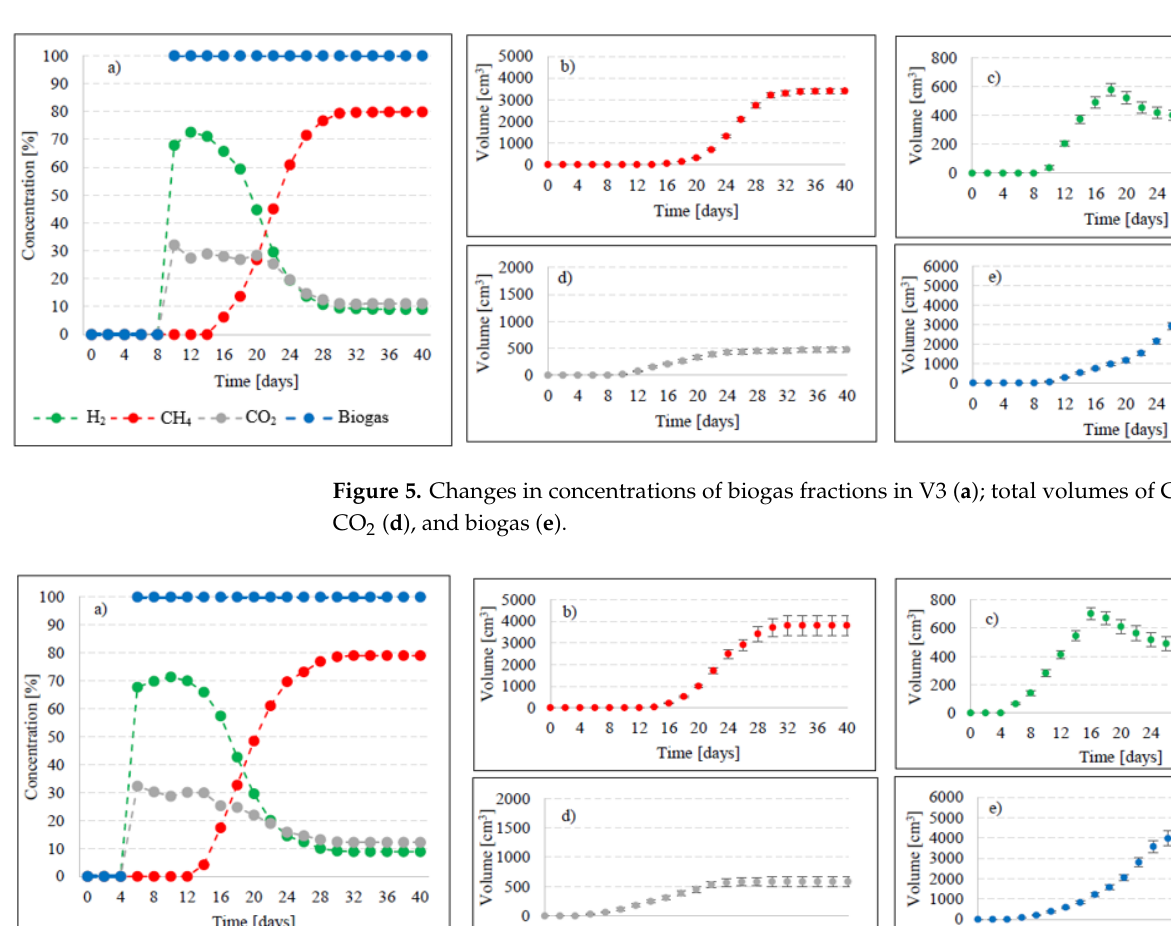
Figure 4. Changes in concentrations of biogas fractions in V2 ( a ); total volumes of CH 4 ( b ), H 2 ( c ), CO 2 ( d ), and biogas ( e ).